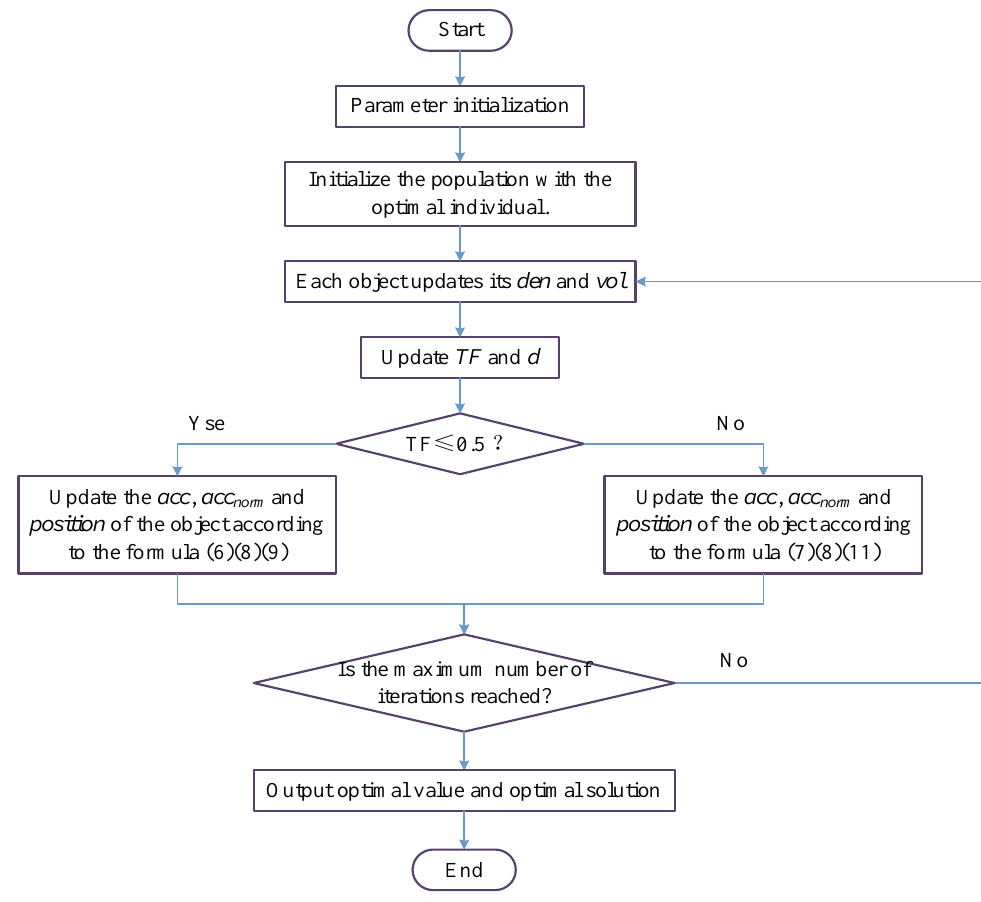
Figure 1. Flow chart of the AOA.